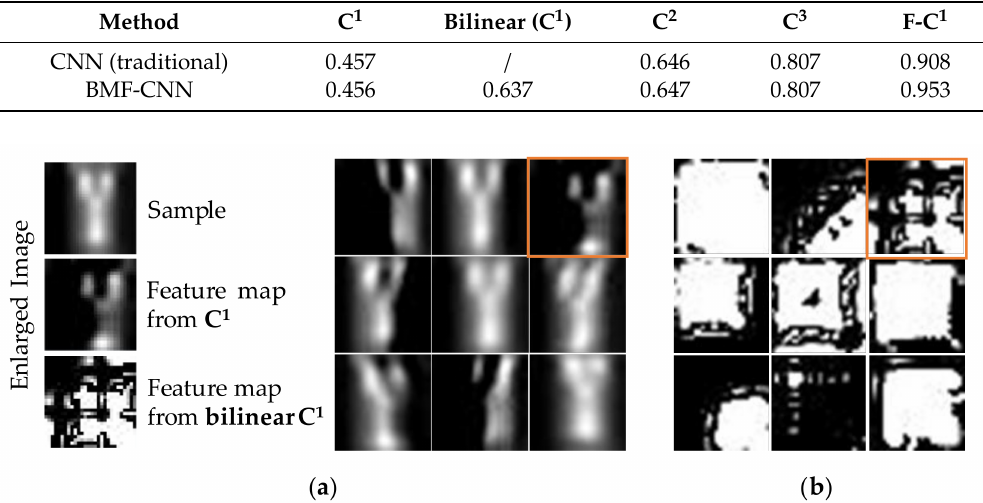
Figure 7. Feature map visualization. ( a )the top-9 activating feature maps in C 1 . ( b ) the corresponding bilinear feature maps of C 1 . The enlarged images are marked by orange box.